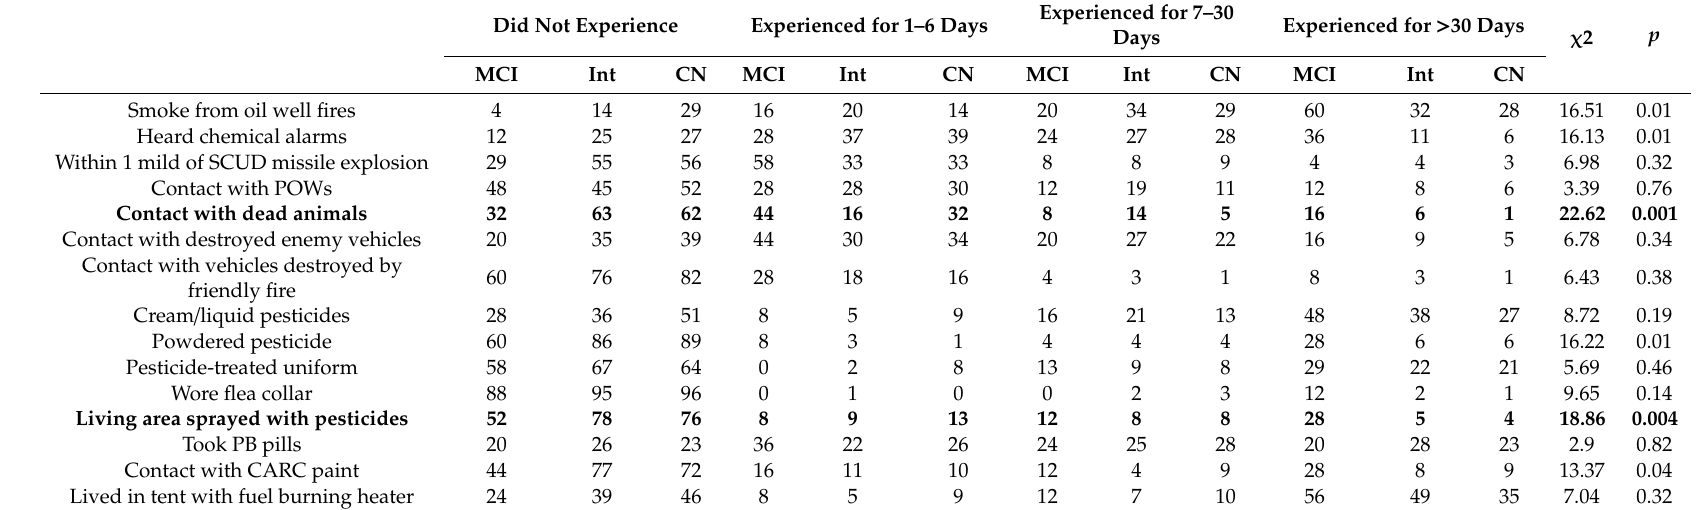
Table 5. Deployment-related exposure or experience as a function of cognitive